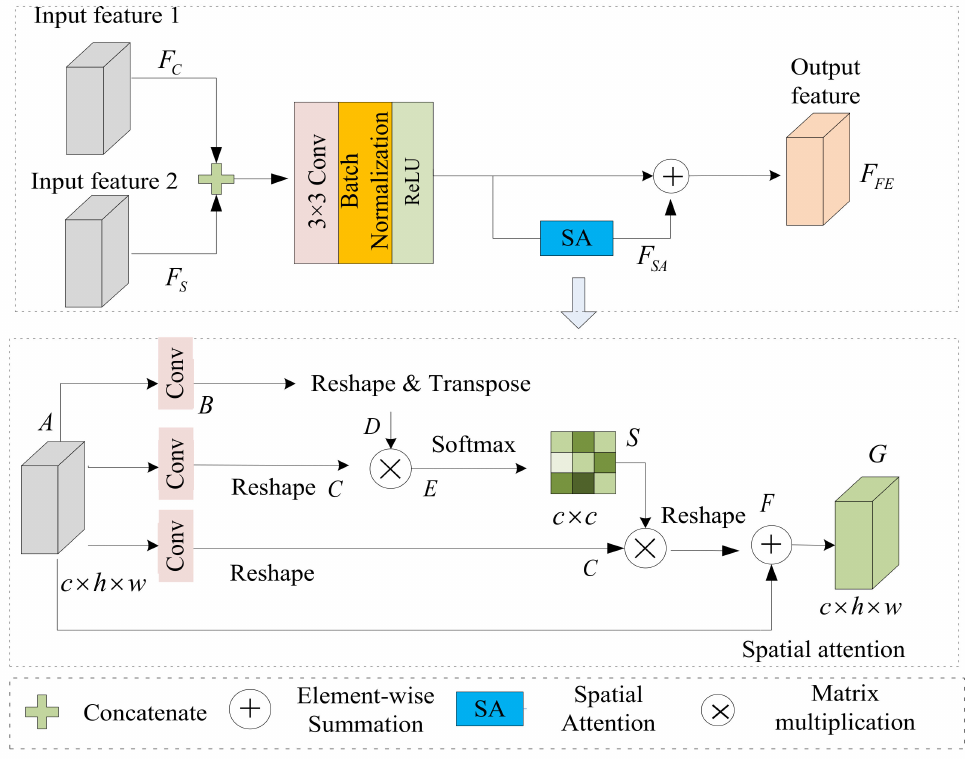
Figure 3. Feature refinement module.